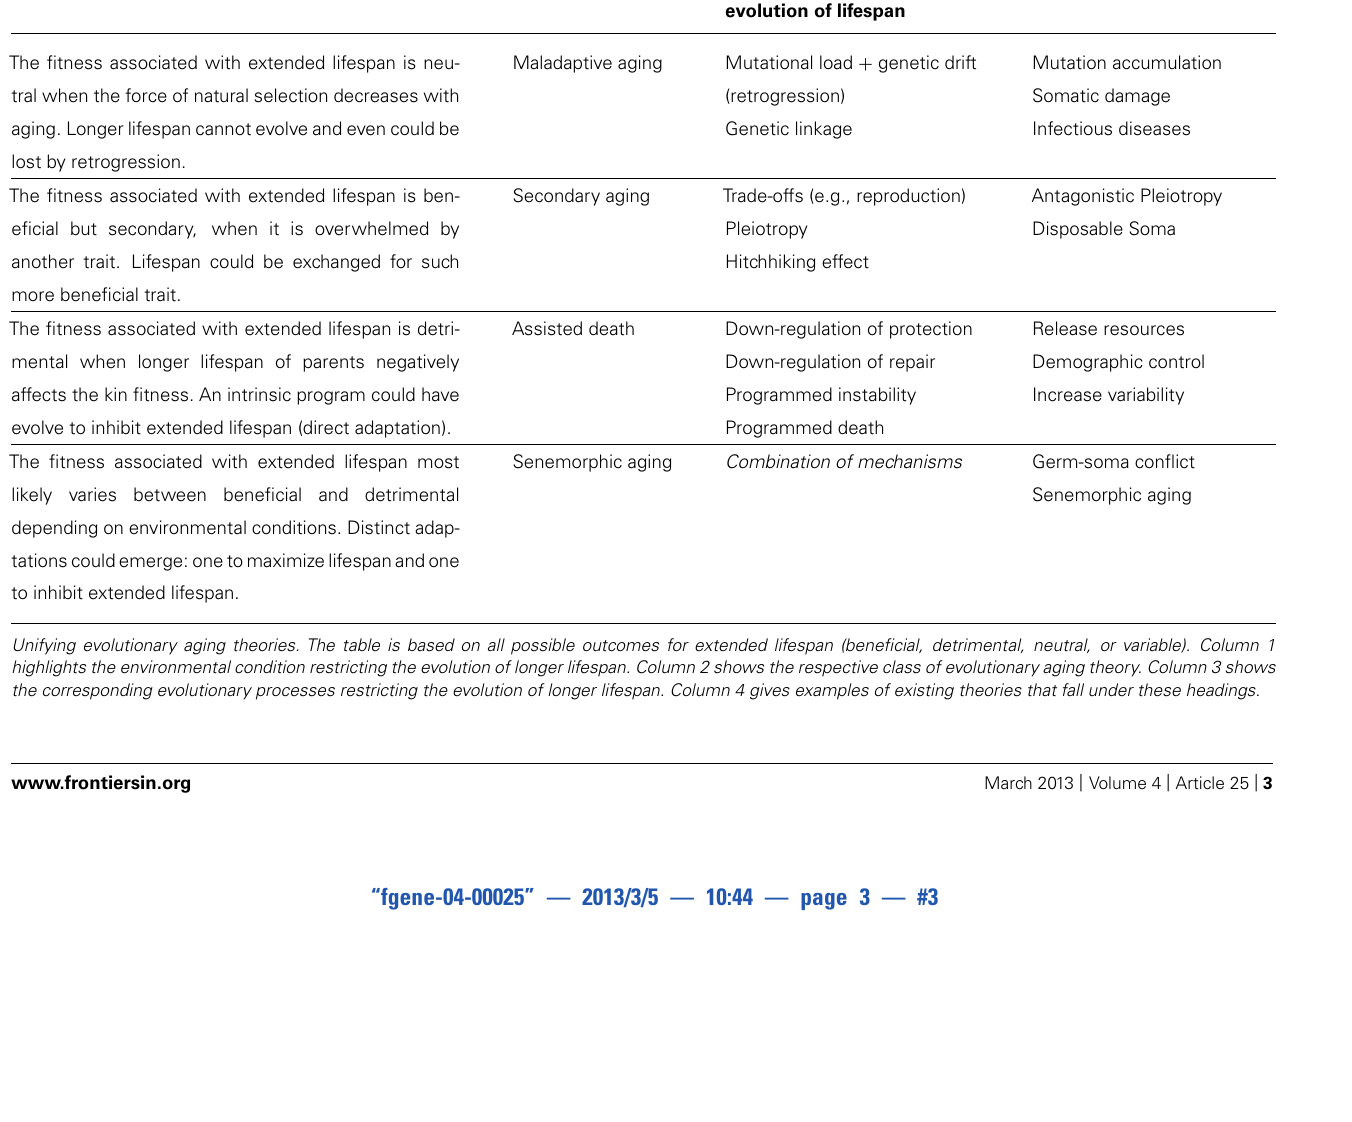
Table 1 | Fitness-based classification system for the evolutionary aging theories. Fitness value/specific environmental conditions